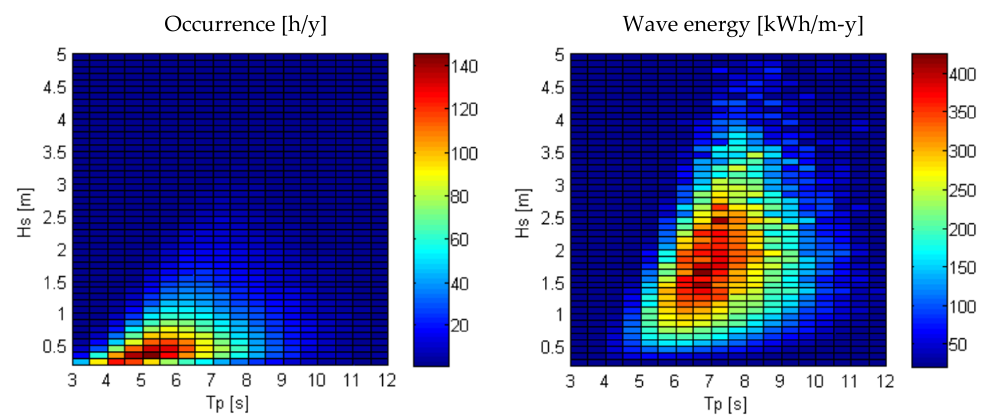
Figure 4. Examples of scatter tables on the island of Pantelleria (Italy) [30].